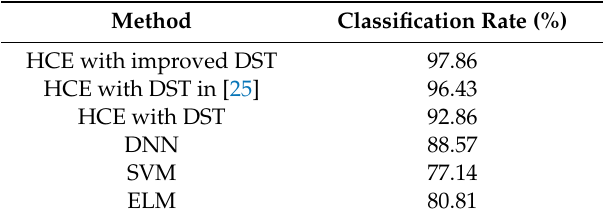
Table 11. Results of classification